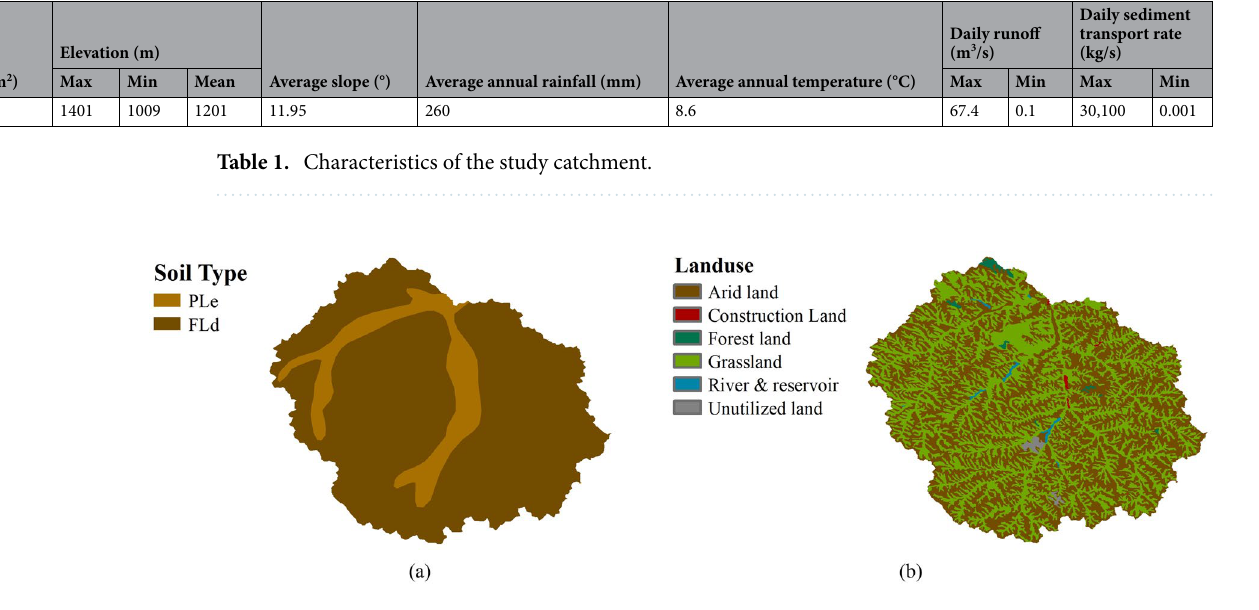
Figure 2. Soil type ( a ) and land use ( b ) of the study area.